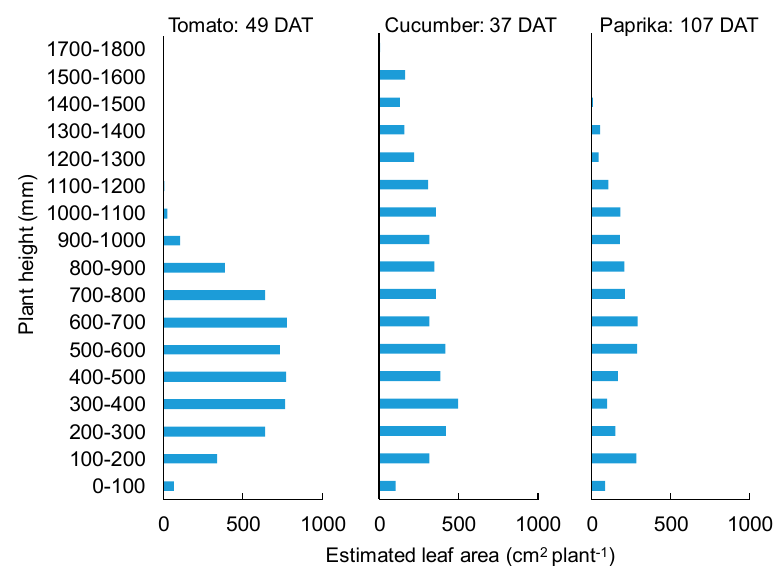
Figure 12. Plant structure estimated based on the height and polygon area of the canopy surface model. Tomato and cucumber canopies were scanned using the 3D scanner (DPI-8X, Opt Technologies Co., Ltd., Tokyo, Japan) on 23 May 2019. Paprika canopies were scanned on 12 June 2019.